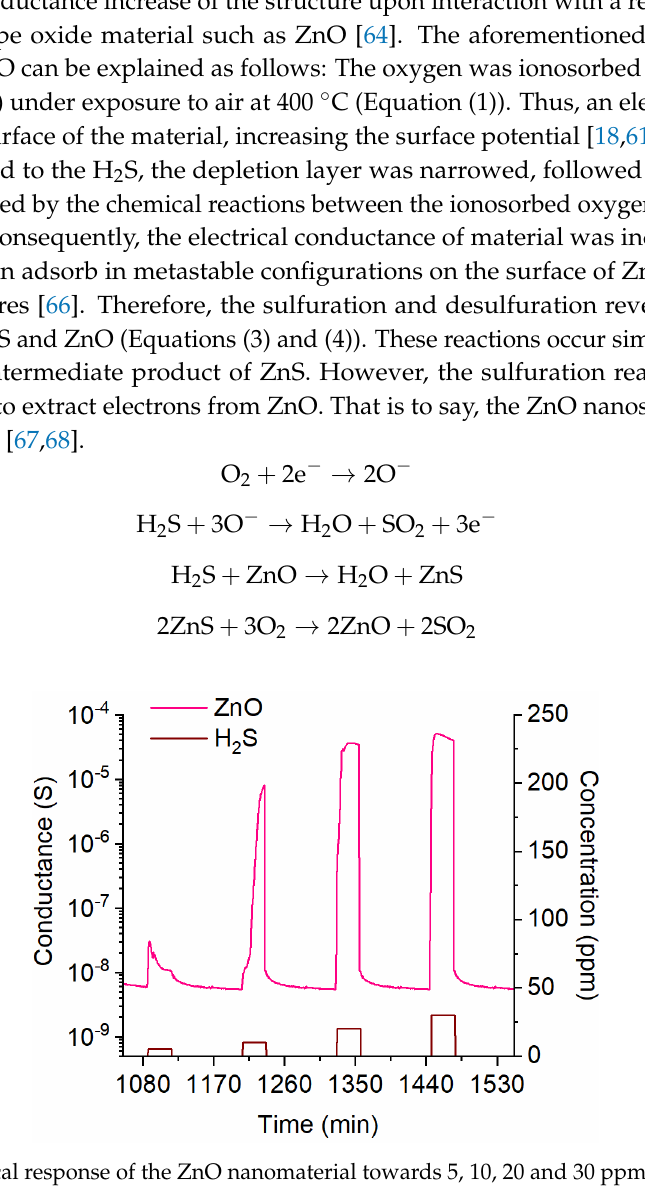
Table 2. Comparison of H 2 S gas sensing properties of the prepared ZnO nanomaterial with the previously reported H 2 S gas sensors based on ZnO. G 0 is the sample conductance in air and G is the sample conductance in the presence of H 2 S. R 0 is the sample resistance in air, R is the sample resistance in the presence of H 2 S. Composition and Morphology